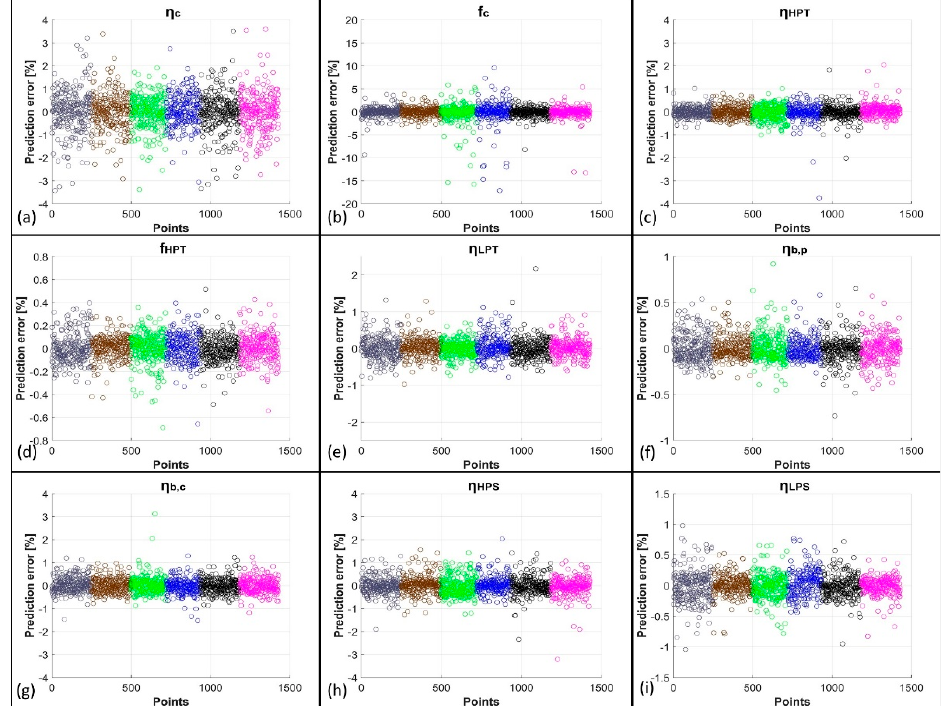
Figure 10. ( a – i ) Percentage errors between KPCA + FFNN predictions and targets about the PPs related to the multi-component degradation condition. Grey: START-A; brown: START-B; green: MAXPOW-A; blue: MAXPOW-B; black: MAXDUR-A; magenta: MAXDUR-B.